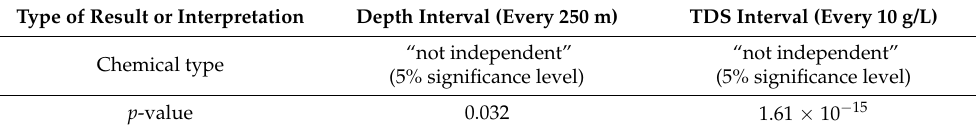
Table 4. Results and interpretation of the Pearson’s Chi-squared test regarding the dependence of the chemical type of water on the depth and TDS.